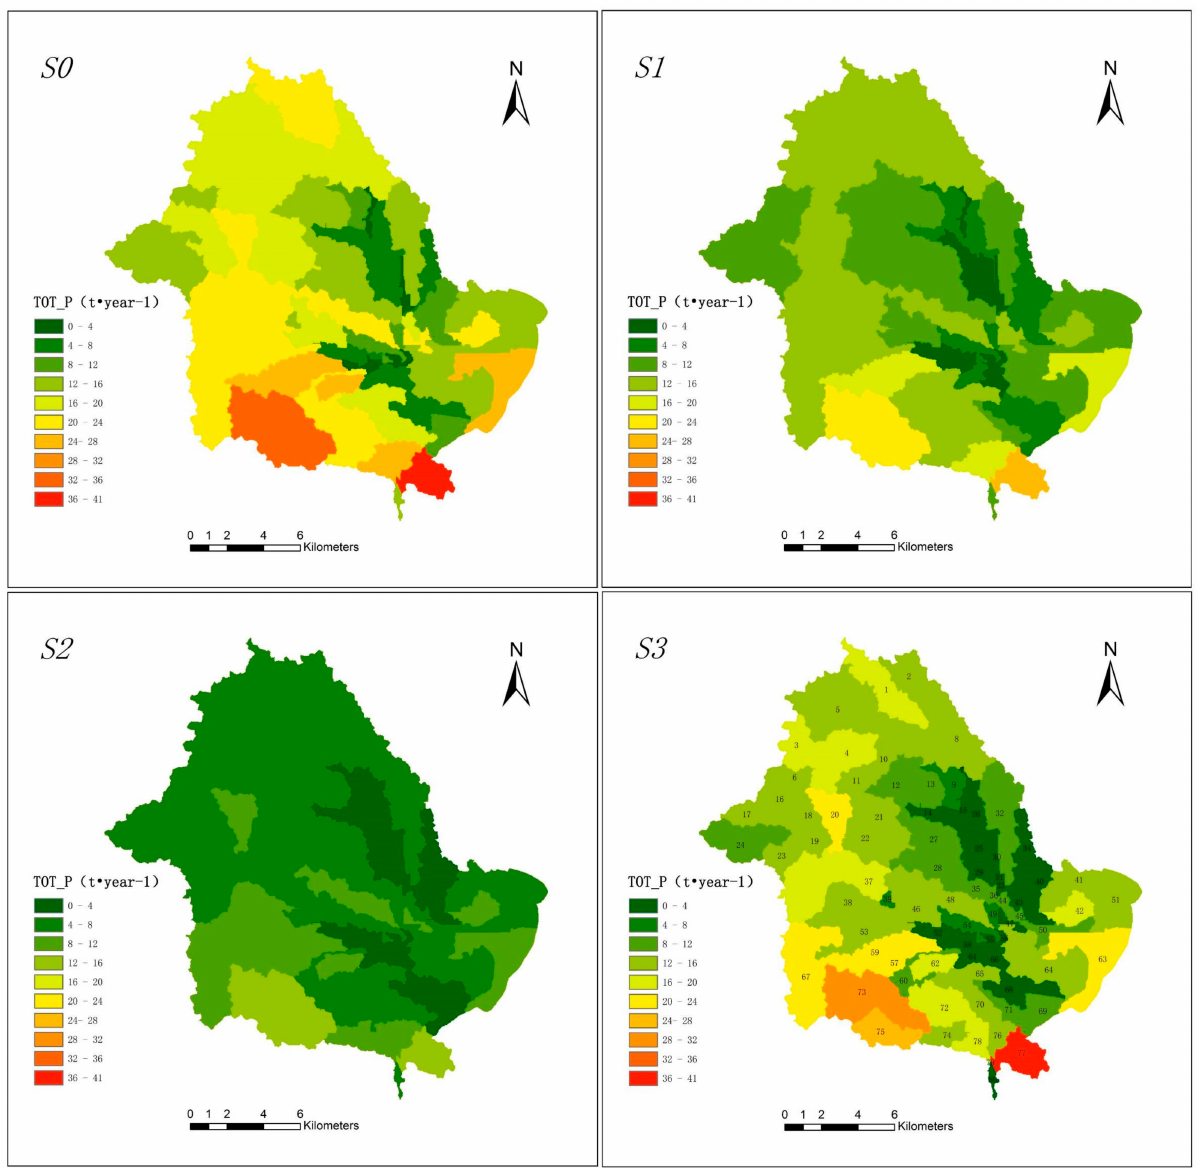
Figure 11. Spatial distribution of TOT_P loss in MLW under different scenarios. S0: current situation; S1: halving fertilization every year; S2: fallow every other year; S3: returning agricultural land to